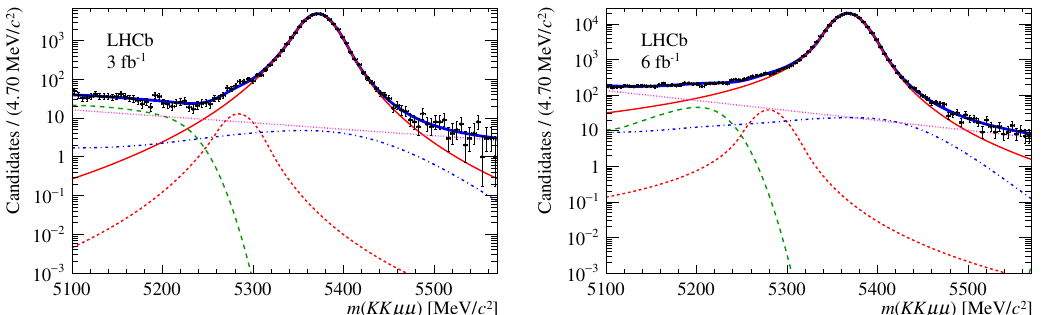
Figure 2. The K + K − µ + µ − mass distributions of selected B 0 → J/ψφ candidates in (left) Run 1 s and (right) Run 2 data, with the fit projections overlaid. The red solid line is B 0 → J/ψφ signal, s the red dashed line is B 0 → J/ψK + K − signal, the green dashed line is the partially reconstructed background component, the violet dotted line is the combinatorial background component, and the blue dash-dot line is the Λ 0 → J/ψpK − background component. b